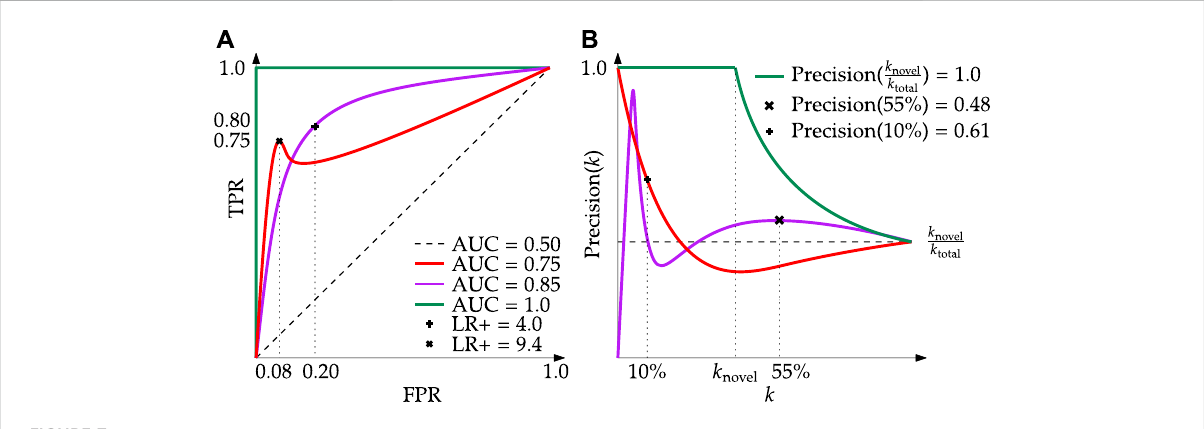
FIGURE 7 Demonstration of the core evaluation metrics used in this research. (A) Receiver Operating Characteristic (ROC) curves with associated AUC andLR+;hereitcanbeseenthatdespitethepurplelinehavingagreaterAUC,awell-selectedmodelfromtheredlinecanachieveaLR+ > 2 ×larger. (B) Precision( k ) curves with representative Precision(% Capacity) values; here it can be seen that despite the purple line displaying better generic performance across the spectrum of k values, at 10% capacity the red line is more